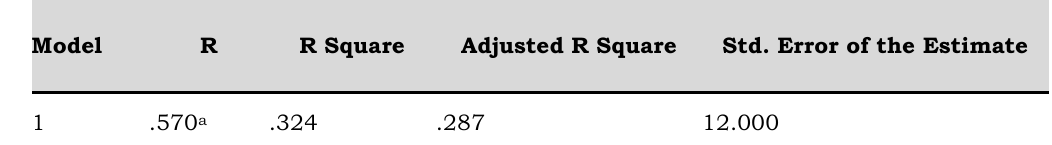
Table 6. Result of regression